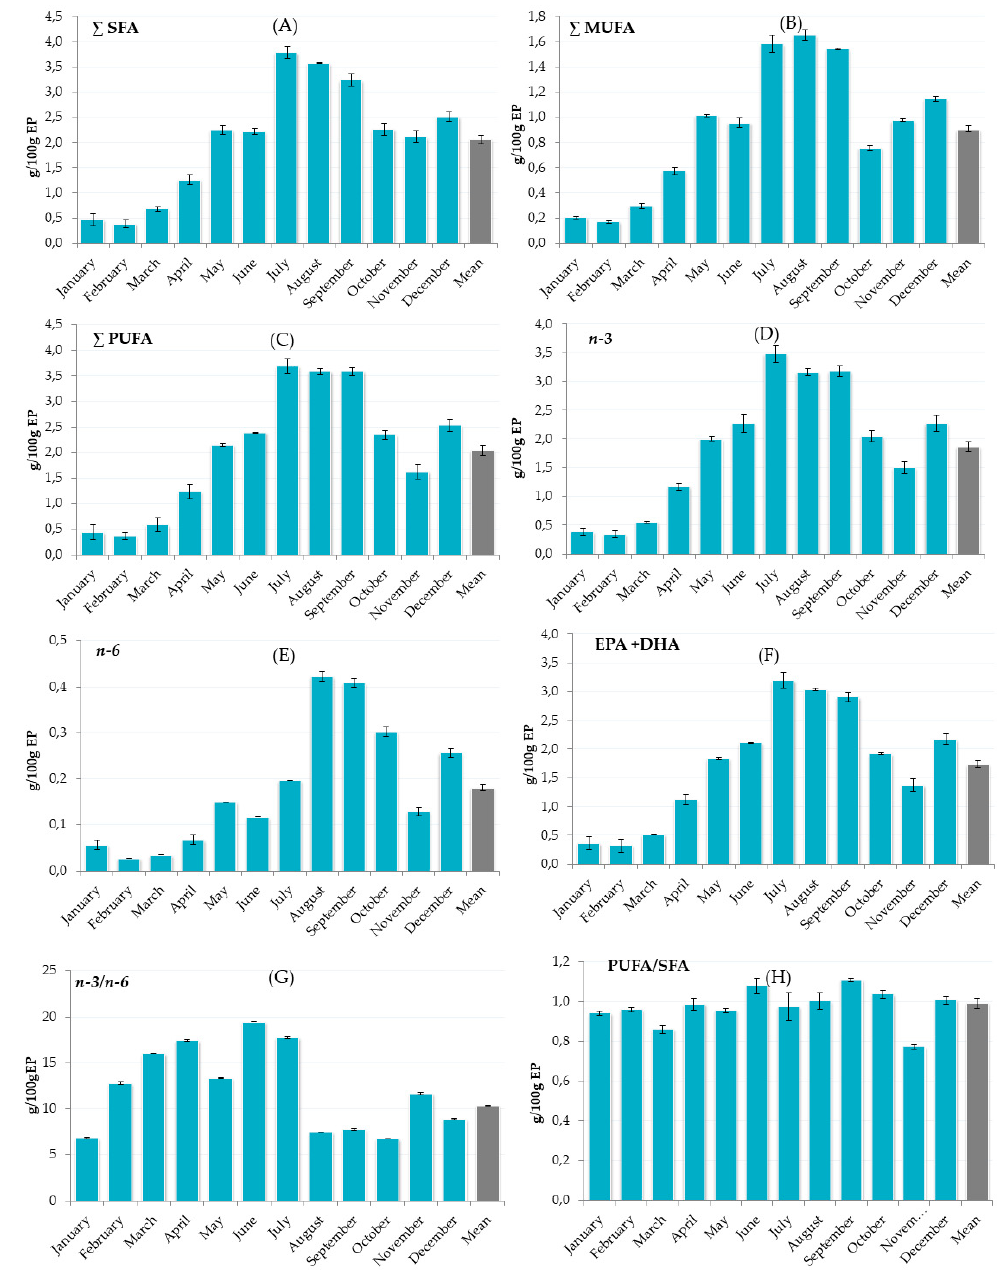
(cid:80) (cid:80) Figure 2. The total sum of saturated fatty acids ( SFA, A ), monounsaturated fatty acids ( MUFA, B ), Figure 2. The total sum of saturated fatty acids ( ∑ SFA, A ), monounsaturated fatty acids ( ∑ MUFA, B ), (cid:80) polyunsaturated fatty acids ( PUFA, C ), total sum of n-3 ( D ) and n-6 ( E ), sum of eicosapentaenoic polyunsaturated fatty acids ( ∑ PUFA, C ), total sum of n ‐ 3 ( D ) and n ‐ 6 ( E ), n ‐ 3/ n ‐ 6 ratio ( G ), and (EPA) and docosahexaenoic (DHA) fatty acids ( F ), n -3 / n -6 ratio ( G ), and PUFA / SFA ratio ( H ) of sardines PUFA/SFA ratio ( H ) of sardines over 12 months. over 12